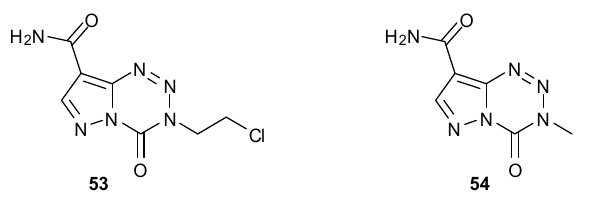
Figure 12. Pyrazolo analogues of MTZ and TMZ